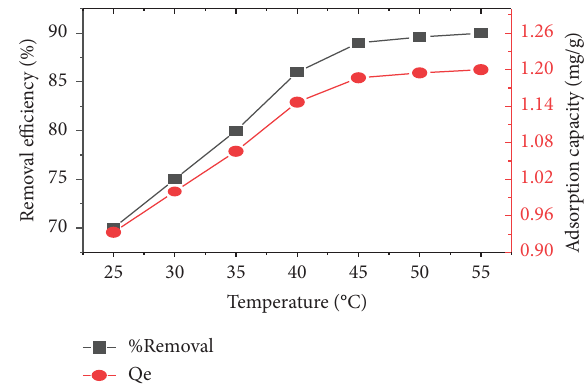
Figure 11: Te infuence of solution temperature on fuoride ion removal percentage and adsorption